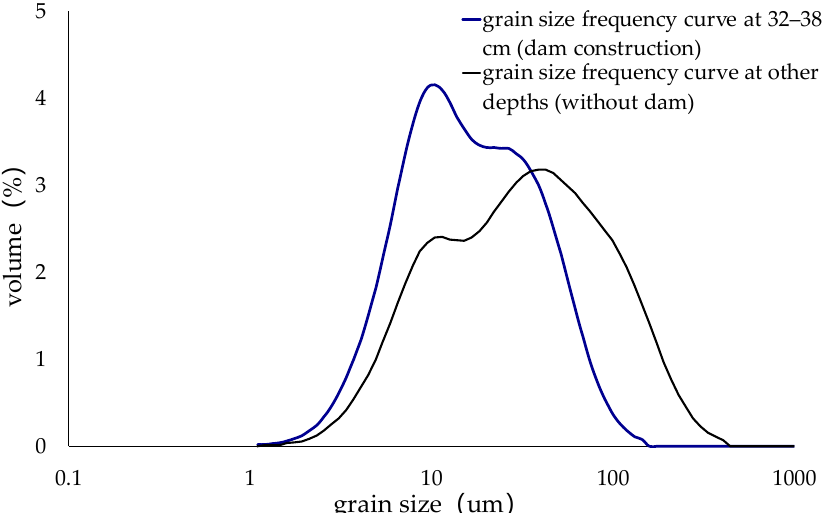
Figure 8. The sketch map of sediment grain size frequency curves at 32–38 cm of the 41 cm core corresponding to the period of dam construction and other depths corresponding to the period without dam.